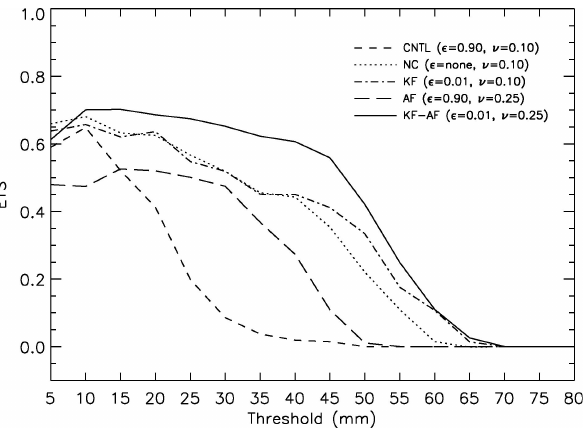
Fig. 1. The ETSs of precipitation forecasts in terms of various thresholds (in mm). Curves denote scores for the 6–12h accumu- lated rainfall forecasts for experiments CNTL (control run with de- fault values), NC (no convective parameterization), KF (using opti- mized parameter in the KF scheme), AF (using optimized parameter in the Asselin filter), and KF-AF (using optimized parameters from both the KF scheme and the Asselin